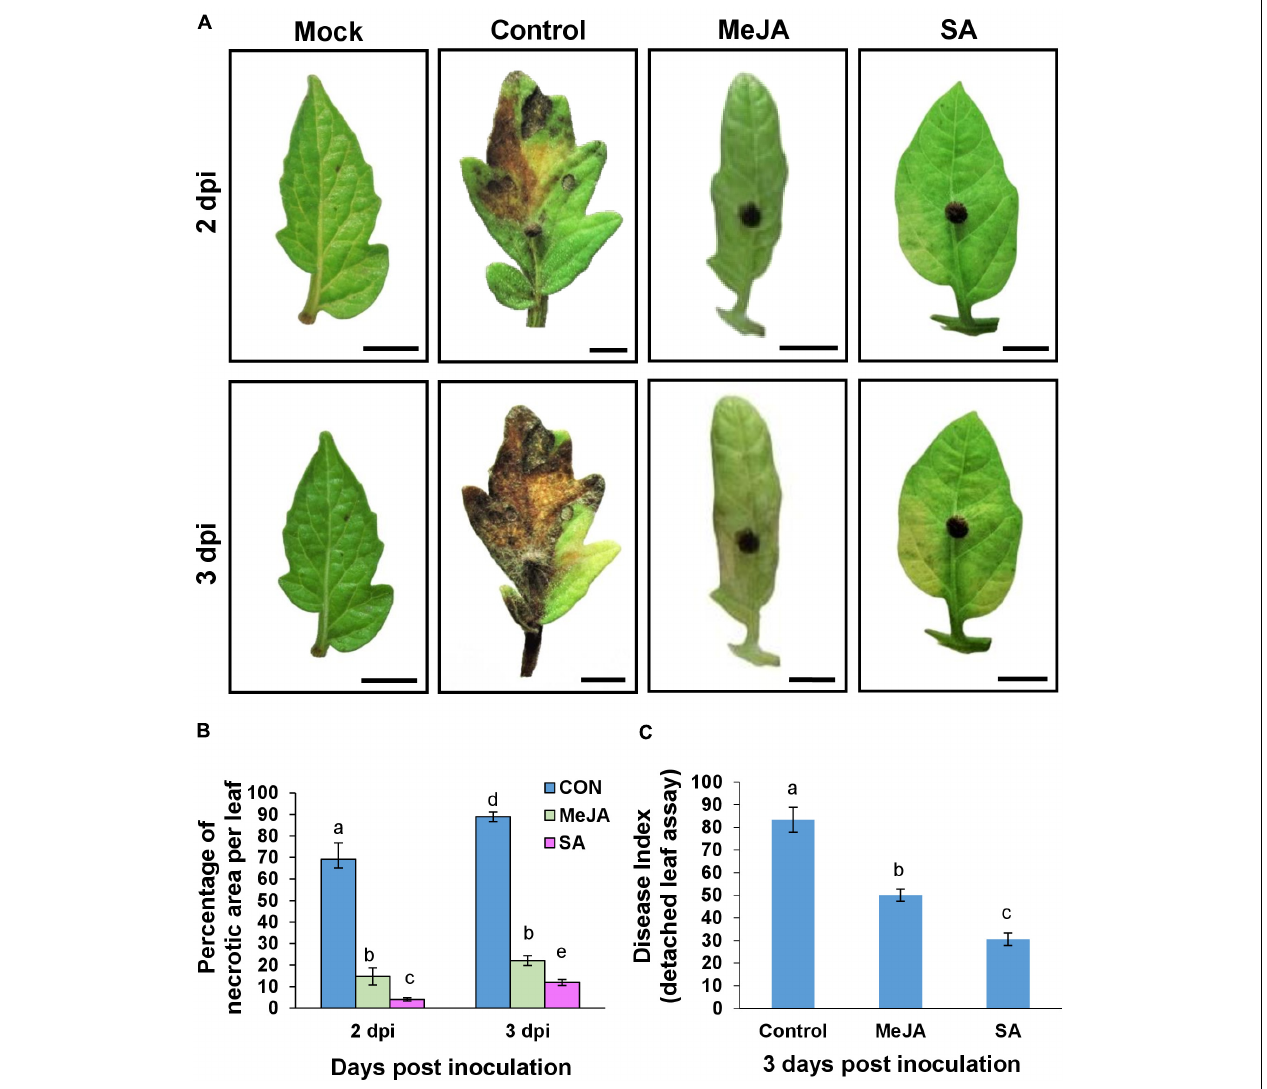
FIGURE 7 | Detached leaf assay showing priming with phytohormones contributed to reduced disease severity and less disease index with SA pre-treatment being more effective than MeJA. (A) Comparison of development of necrotic lesions at 2 and 3 dpi on control and phytohormone treated tomato leaves after inoculation with R. solani . At 2 dpi the control set leaves develop significant necrotic lesions whereas MeJA and SA-primed leaves remained almost as fresh as the unprimed, uninoculated (mock) leaves. Control leaves get almost entirely necrosed by 3 dpi while MeJA and SA-treated leaves show significantly less necrosis. (B) Graph showing comparison of the percentage of necrotic lesion on leaves from the above experiment. (C) Disease index at day 3 showing that SA pretreatment results in least disease index. Bars represent mean ± S.E.M of three independent experiments with three replicates. Different letters indicate significant differences among treatments at p < 0.05, according to Duncan’s multiple range